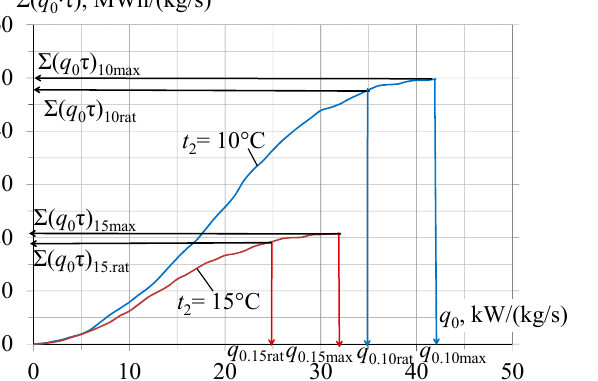
Figure 1. Specific annual refrigeration energy consumption ∑ ( q 0 · τ ) and the rational values q 0.rat when conditioning air to t a 2 = 10, 15 °C, and 20 °C.